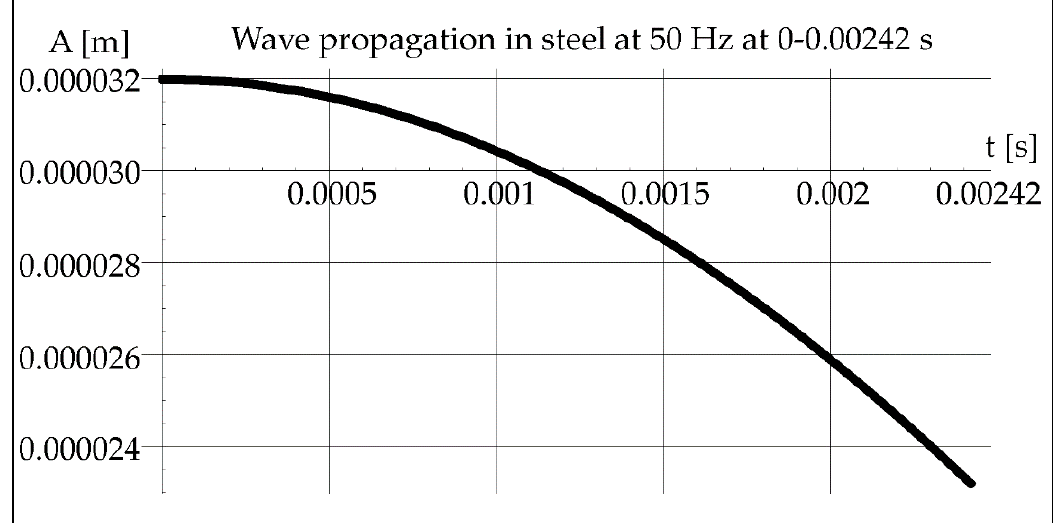
Figure 4. Propagation of acoustic wave in steel at 50 Hz during 0–0.00242 s.